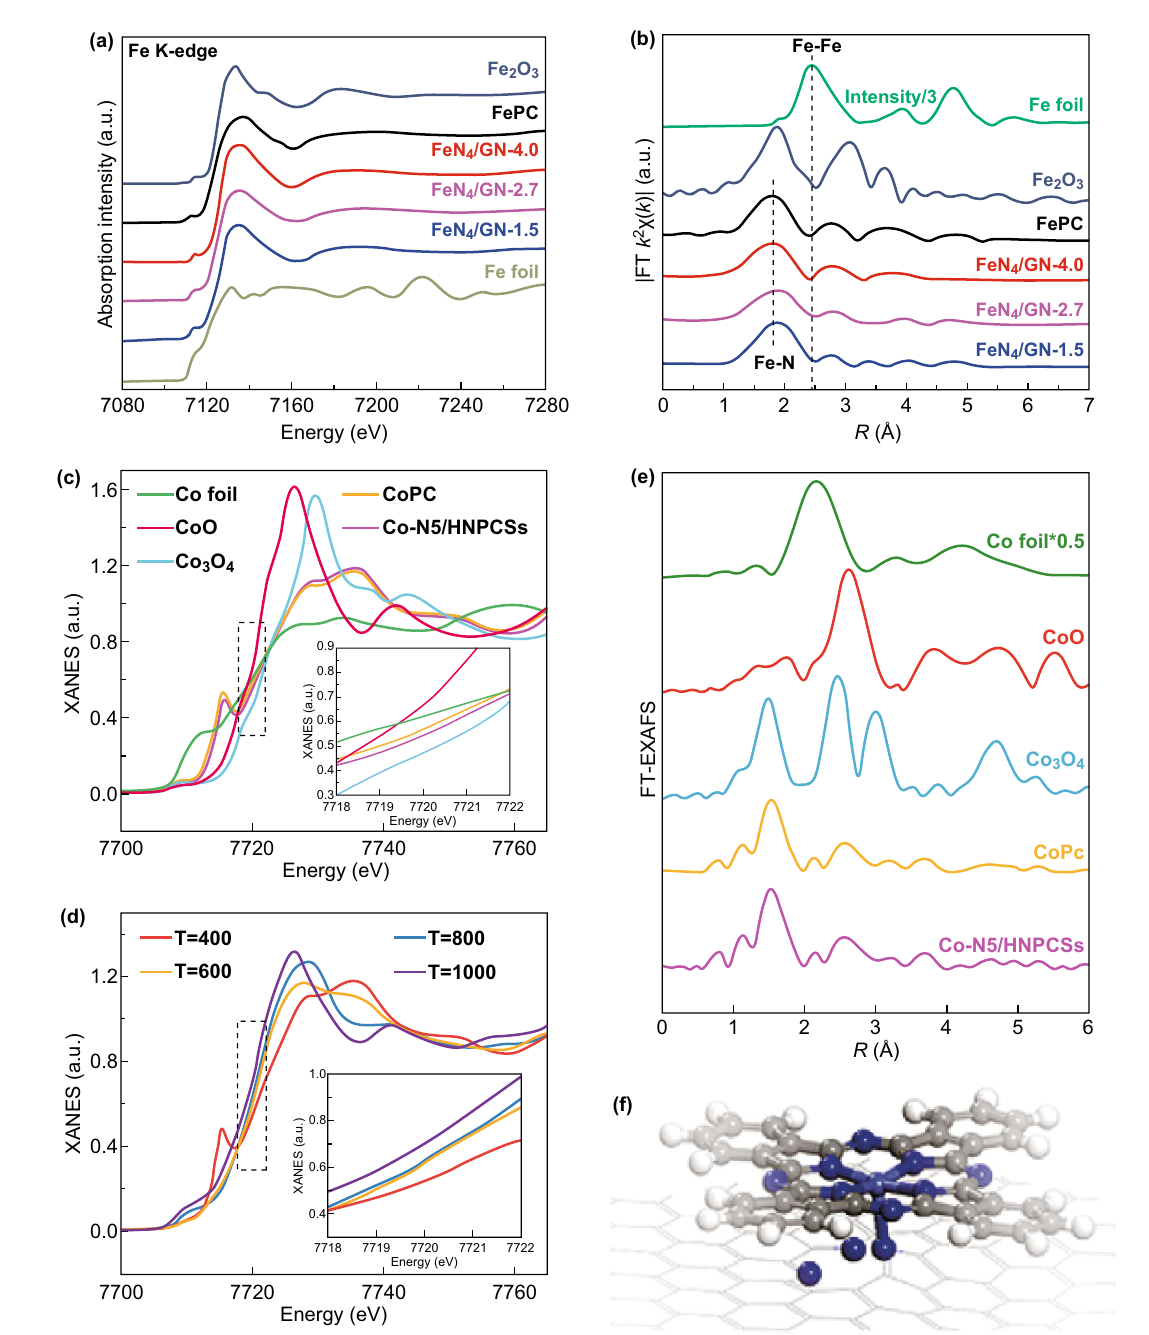
Fig. 9 a Fe K-edge XANES and b FT-EXAFS signals for FeN 4 /GN, FePc, Fe foil, and Fe 2 O 3 . XANES spectra at the Co K-edge of c Co 3 O 4 , Co foil, CoO, and Co-N 5 /HNPCSs, d Co-N 5 /HNPCSs-T (inset is the magnified image), e FT at R space, f schematic model, C (gray), N (blue), Co (wathet), and H (white). a–b Reproduced from Ref. [78] with permission. Copyright 2017 Wiley-VCH. c – f Reproduced from Ref. [149]